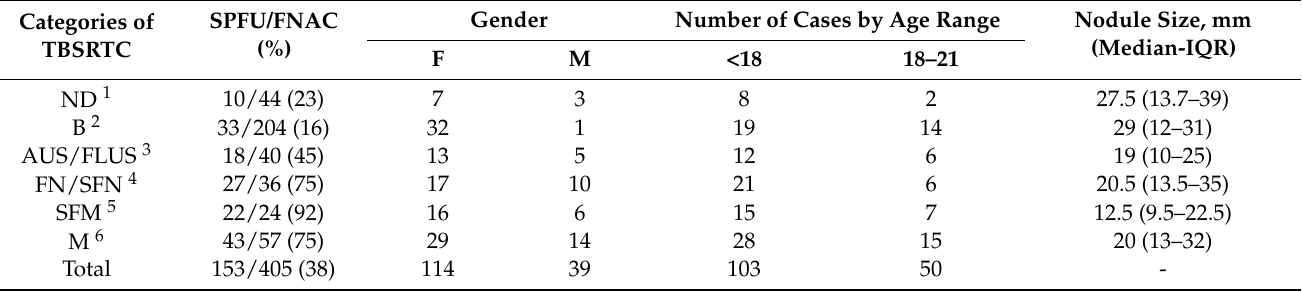
Table 2. The Demographic data of the cases subject to SPFU according to TBSRTC categories.